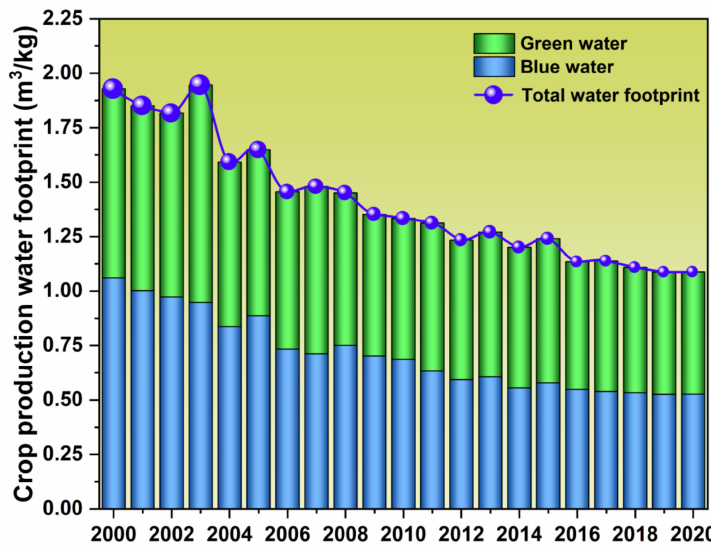
Figure 4. Evolution characteristics of crop water footprint over